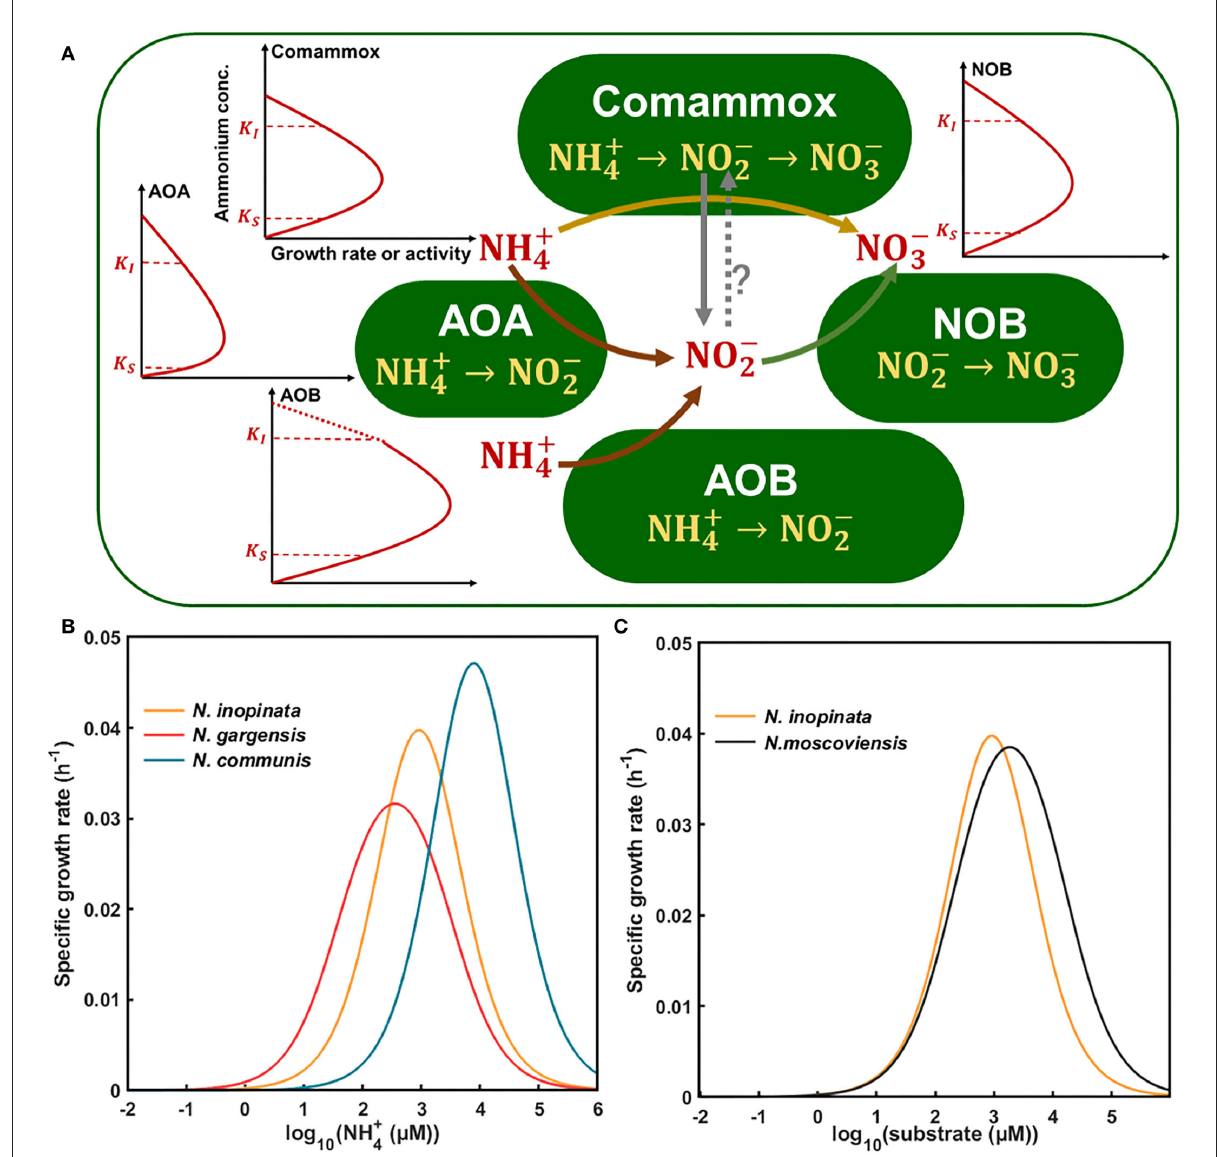
FIGURE6 Conceptual framework for kinetics-driven niche differentiation of four nitrifiers ( N. inopinata , N. gargensis , N. communis , and N. moscoviensis ) in response to ammonium or nitrite. (A) Kinetics of nitrifiers including ammonia affinity, maximum specific growth rate or activity, and substrate inhibition under a wide gradient of ammonium concentrations. Words in red represent extracellular or environmental substances, and words in yellow represent intracellular metabolic pathways for nitrification processes with ammonium as substrate. The solid lines with arrows show the direction of pathways, and the dotted line with arrows and a question mark means uncertain. The red solid lines represent the growth or activity of nitrifiers in response to substrate concentrations, and the dotted part of line of AOB is a theoretical extension for potential inhibition at high ammonium concentrations as no obvious inhibition was observed in this study. (B) Niche differentiation of N. inopinata , N. gargensis , and N. communis in response to a wide gradient of ammonium concentrations based on our study. (C) Niche differentiation of N. inopinata and N. moscoviensis in response to nitrite with ammonium as substrate. K S was represented by K m(app) in Table 2 (282, 42, 2,553, and 228 µ M total ammonium or nitrite, respectively); K I of N. inopinata and N. communis was from Table 2, and K I of N. gargensis and N. moscoviensis was obtained from the literature and modified (Hatzenpichler et al., 2008; Nowka et al., 2015). The specific growth rates of nitrifiers from N1, N2A, and N2B communities (0.064, 0.039, 0.078, and 0.048 h − 1 ) were used for the Haldane model.